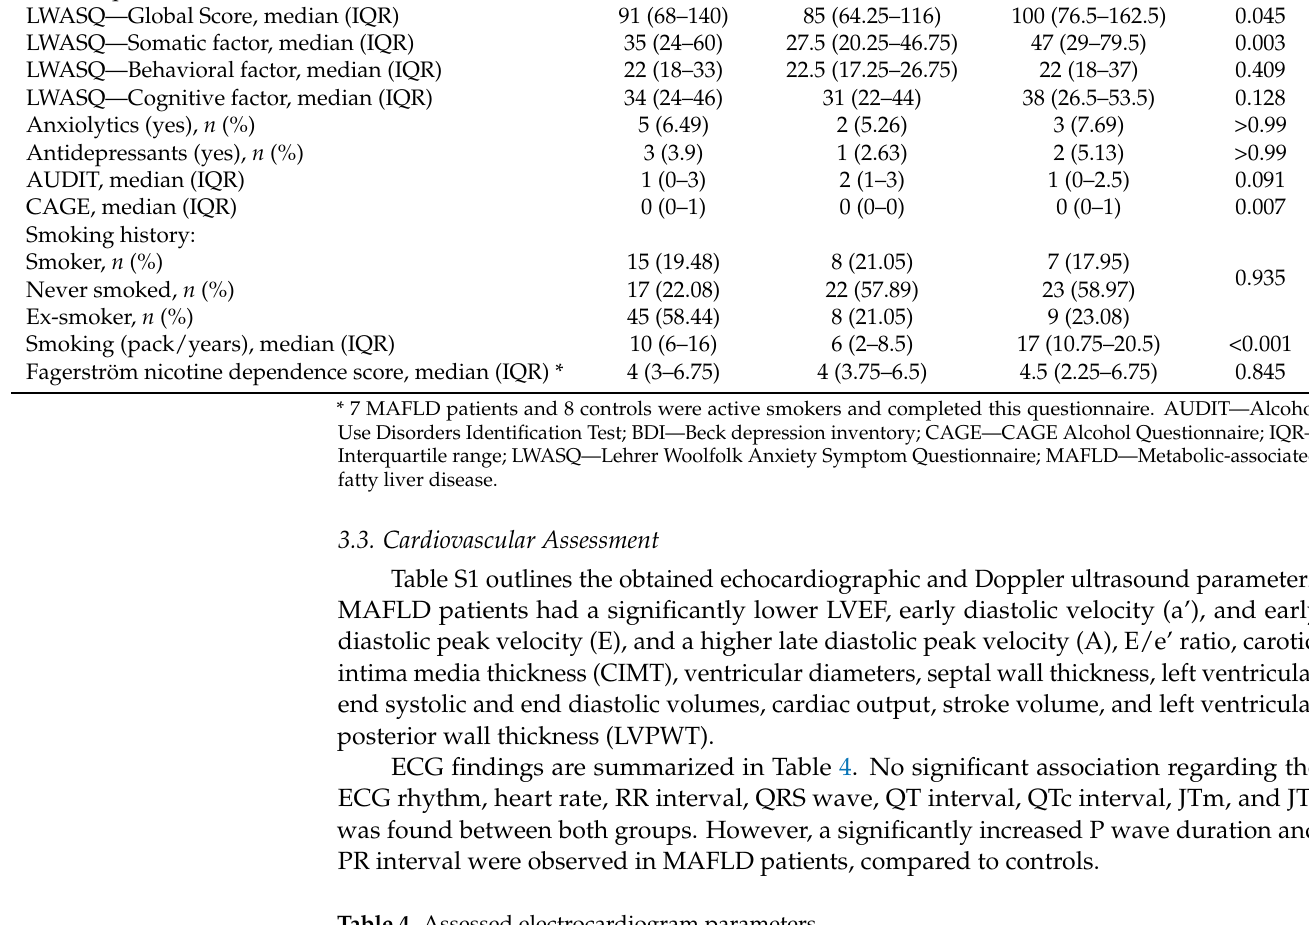
Table 3. Assessment of anxiety, depression, alcohol consumption, and smoking.